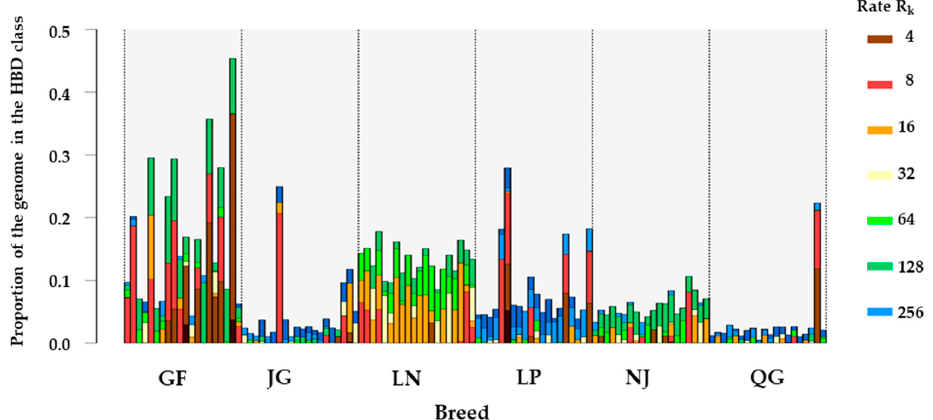
Figure 8. Partitioning of the genome in different homozygosity by descent (HBD) classes in six goat populations. The results are plotted for 20 randomly selected individuals per population. The height of each bar represents the proportion of the genome associated with the HBD class of the corresponding color.